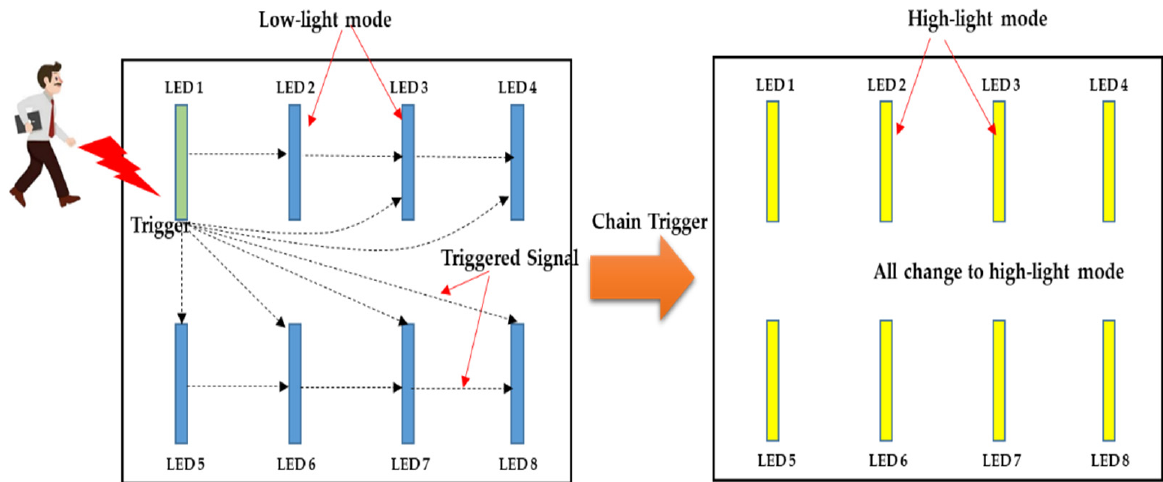
Figure 1. A scenario where all the LED lights in zone 1 change to high-light mode at the same time.